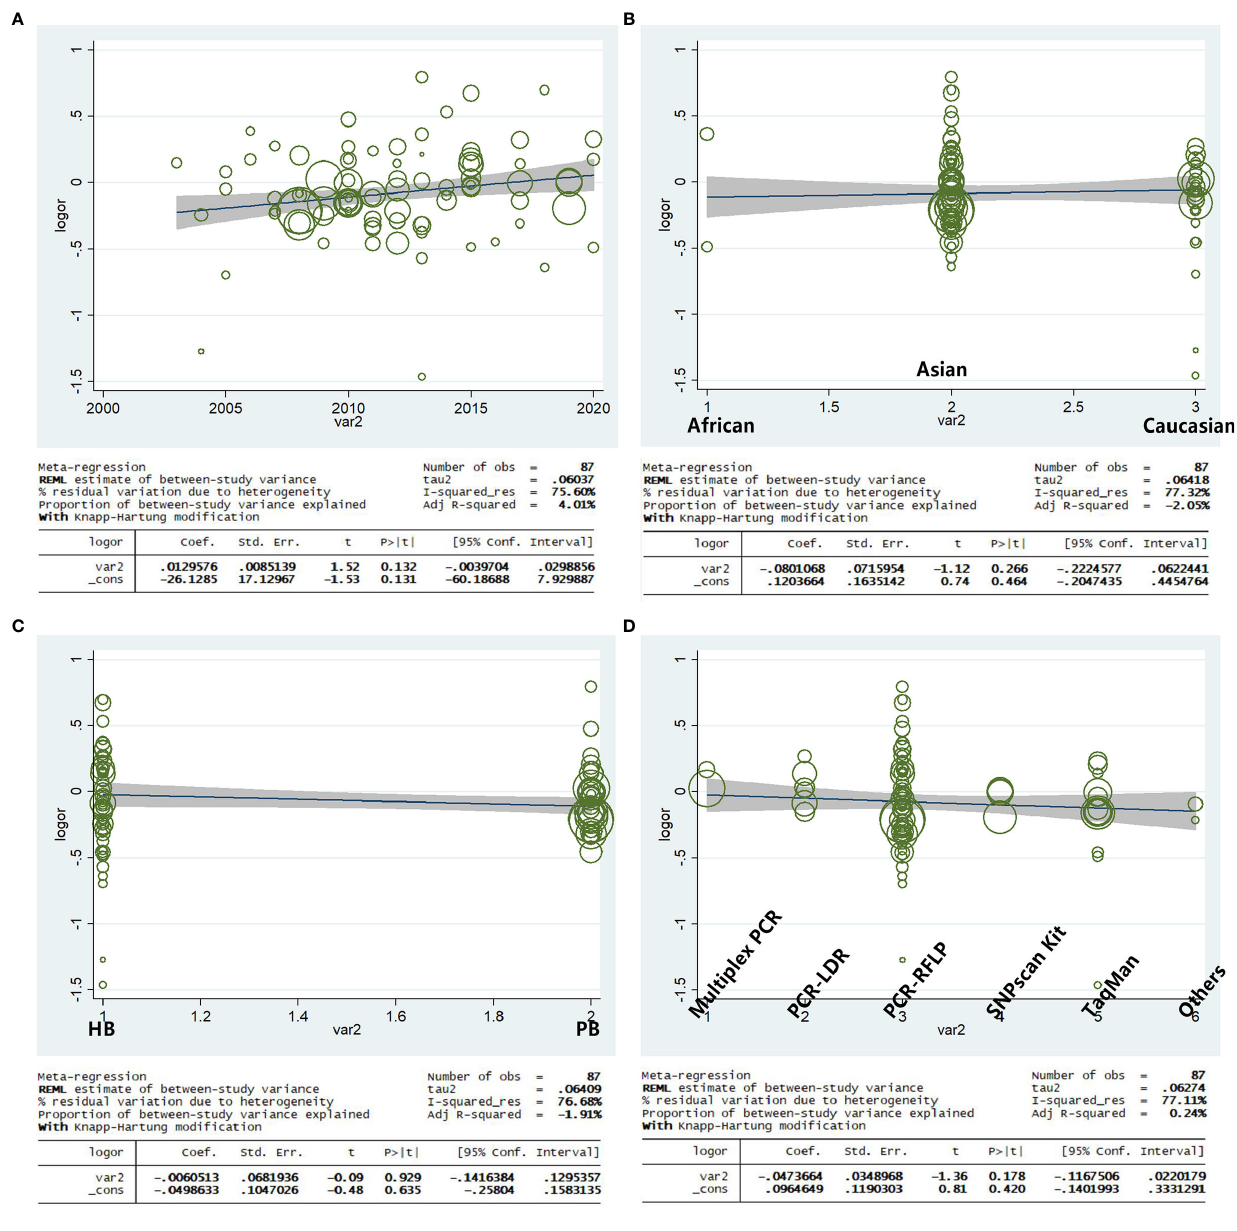
FIGURE 11 | Random-effect meta-regression of log odds ratio vs. publication year (A) , regular ethnicity (B) , source of control (C) , and genotype methods (D) ,